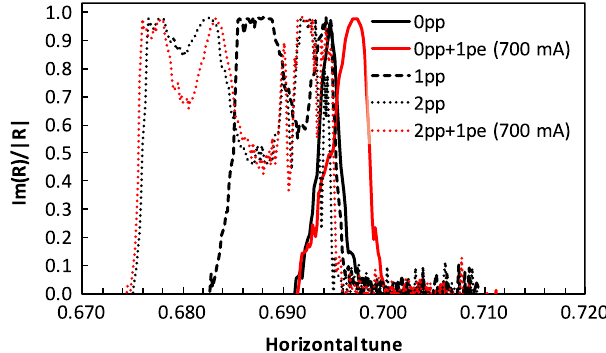
FIG. 13. Reconstructed tune distribution widths from BTF measurements without beam-beam interaction (solid black), with electron lens (solid red), with 1 (dashed black) and 2 (dotted black) beam-beam interactions, and with 2 beam-beam interactions and an electron lens (dotted red). The widths is of colliding beam distributions is determined by the distance of the coherent modes, not by the incoherent tune